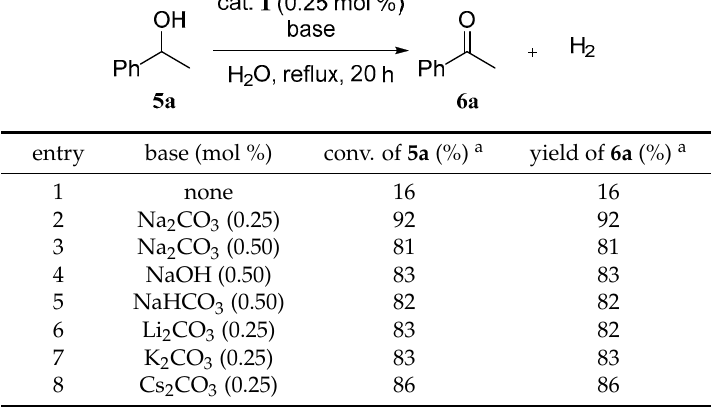
Table 2. Optimization of the basic additive for the dehydrogenative oxidation of 5a to 6a catalyzed by 1 in aqueous media.